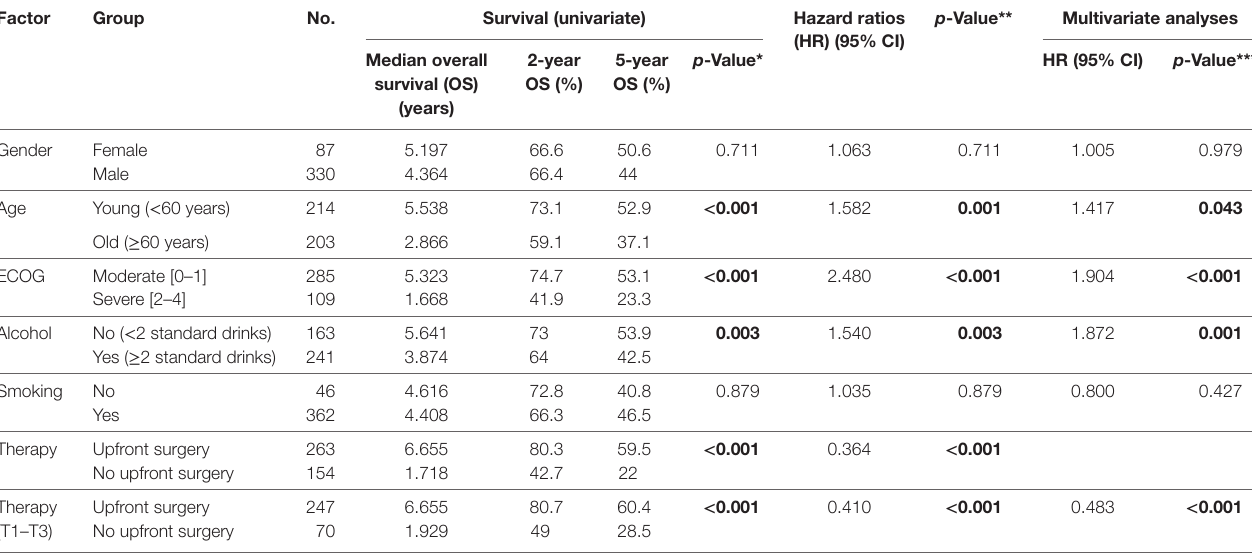
taBLe 5 | Prognostic factors for survival in human papilloma virus-negative patients with oropharyngeal